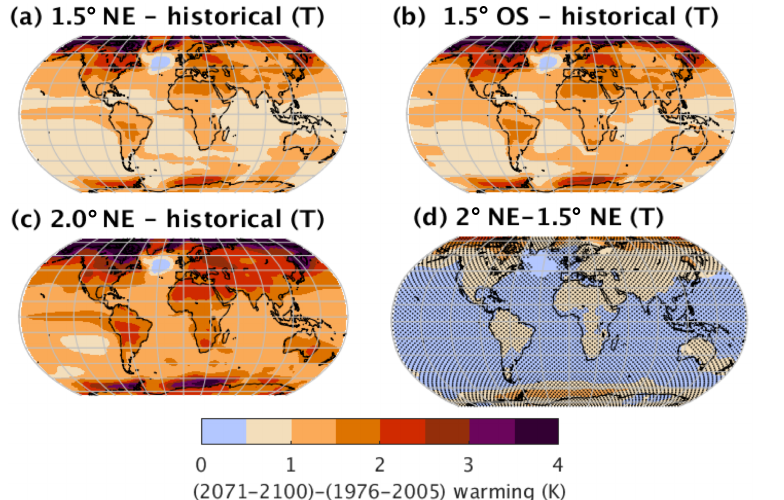
Figure 2. Maps showing ensemble mean 2071–2100 temperature changes relative to 1976–2005 historical conditions in 1.5degNE (a) , 1.5degOS (b) , 2.0degNE (c) scenarios. Subplot (d) shows the difference between mean 2080–2100 conditions in 1.5degNE and 2.0degNE, where significant regions are stippled. Significance is defined as a pixel in which the difference between the mean of the 2.0degNE and 1.5degNE ensembles exceeds the SD of 2080–2100 values in the 2.0degNE